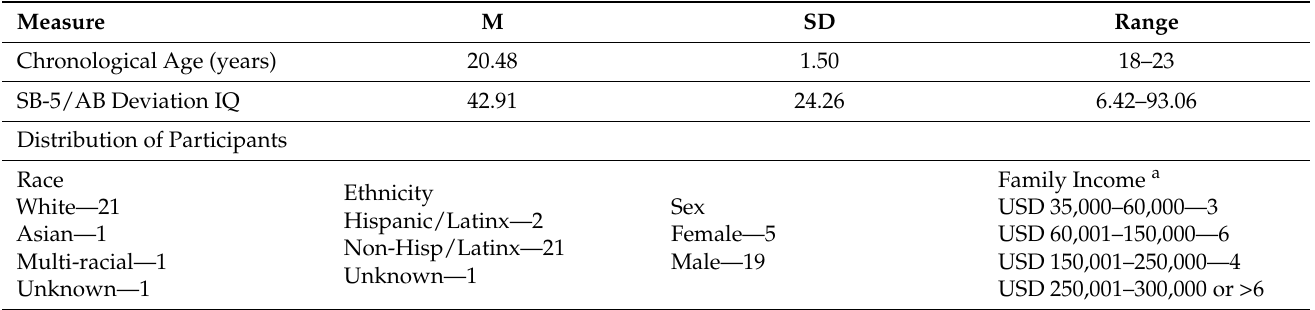
Table 1. Characteristics of Participating Youth with